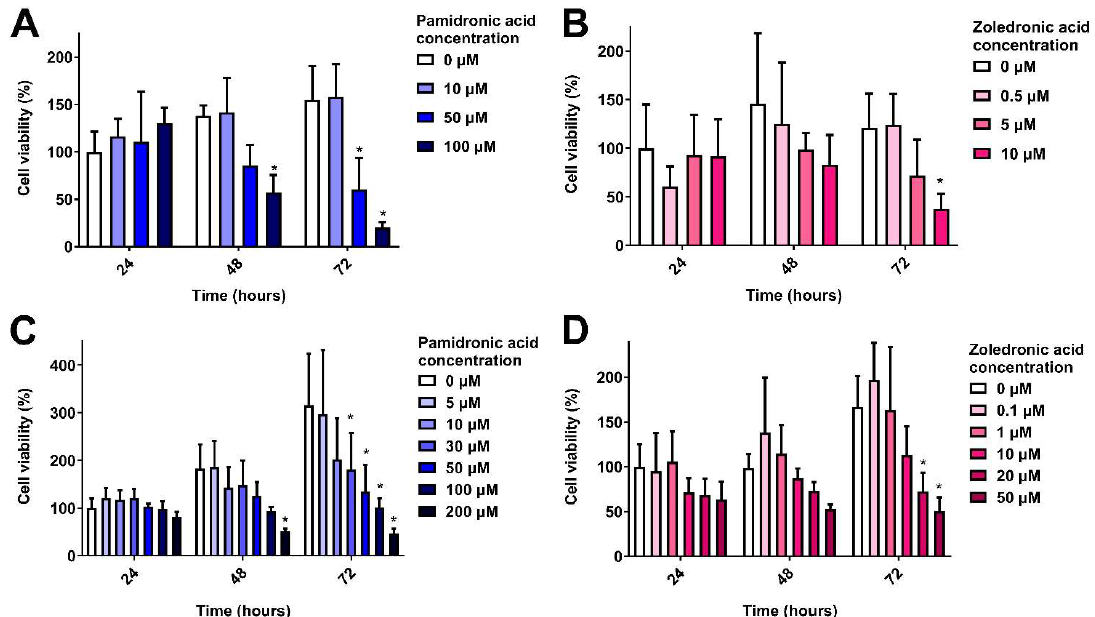
Figure 2. Cell metabolic activity over 72 h in the presence of bisphosphonates measured by MTT assay. ( A ) Human oral fibroblasts with pamidronic acid, ( B ) human oral fibroblasts with zoledronic acid, ( C ) immortalised human oral keratinocytes with pamidronic acid and ( D ) immortalised human oral keratinocytes with zoledronic acid. Values normalised to 0 µM at 24 h. One significant outlying value removed. N = 3, n = 3. Error bars = standard deviation (SD). Significance against 0 µM at each time point indicated by *p ≤ 0.05.